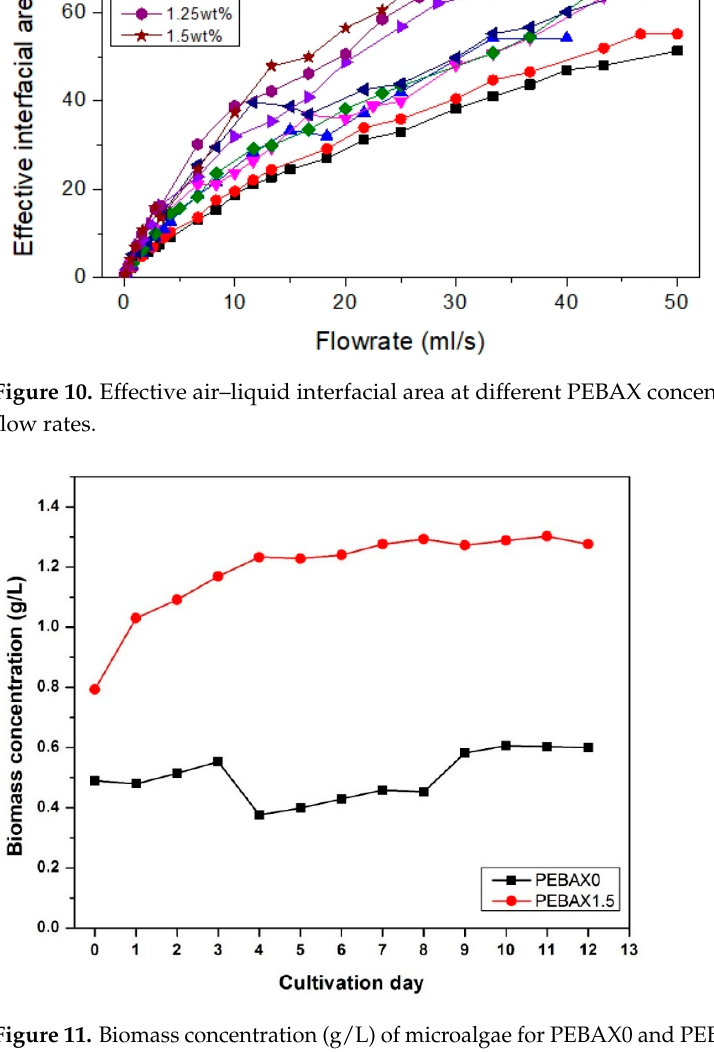
Figure 10. Effective air–liquid interfacial area at different PEBAX concentration under different air flow rates.